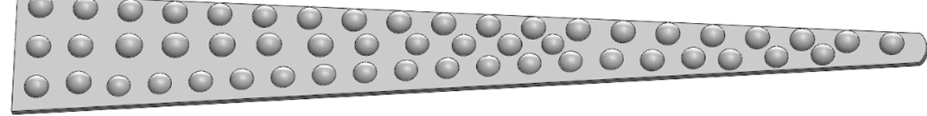
Figure 3. Dimpled section of a turbine blade.